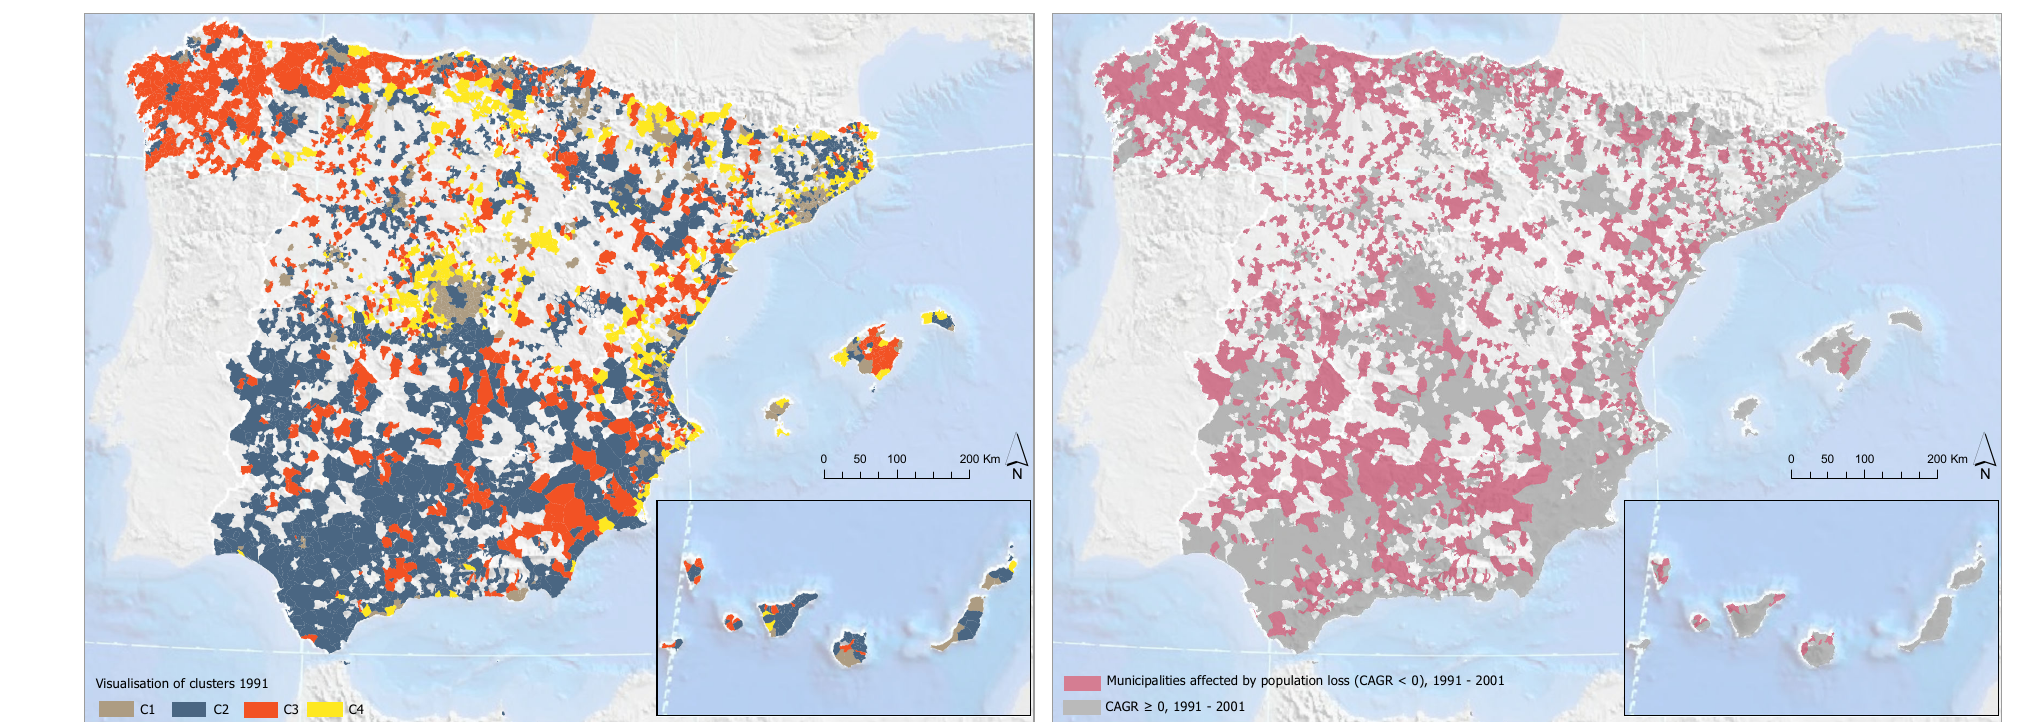
Figure A1. Maps showing the clusters of municipalities from a geographical perspective (part